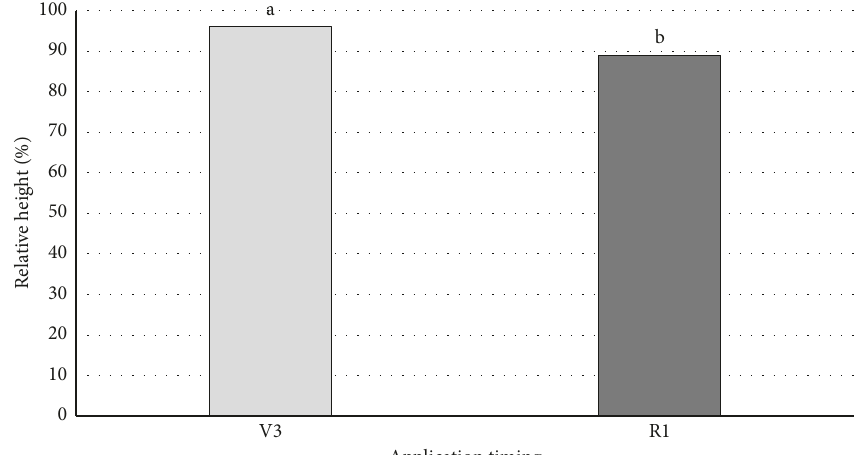
Figure 3: Soybean heights collected at maturity and made relative to the nontreated check according to the main effect of application timing for the cultivar experiment conducted in Fayetteville, AR, in 2018. Treatments not sharing any lowercase letter are significantly different according to multiple comparison analysis α � 0.05